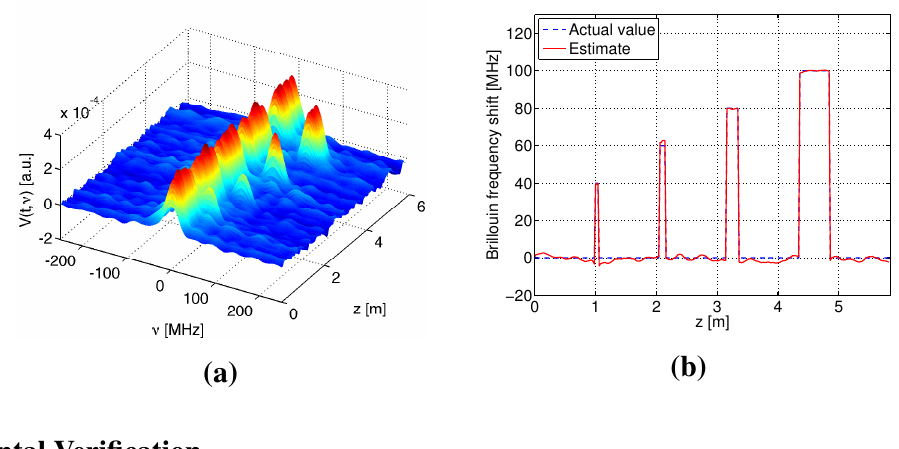
Figure 13. Simulation results of S-BOTDR with D ( a ) the composite Brillouin spectrum and ( b ) the estimate of BFS.